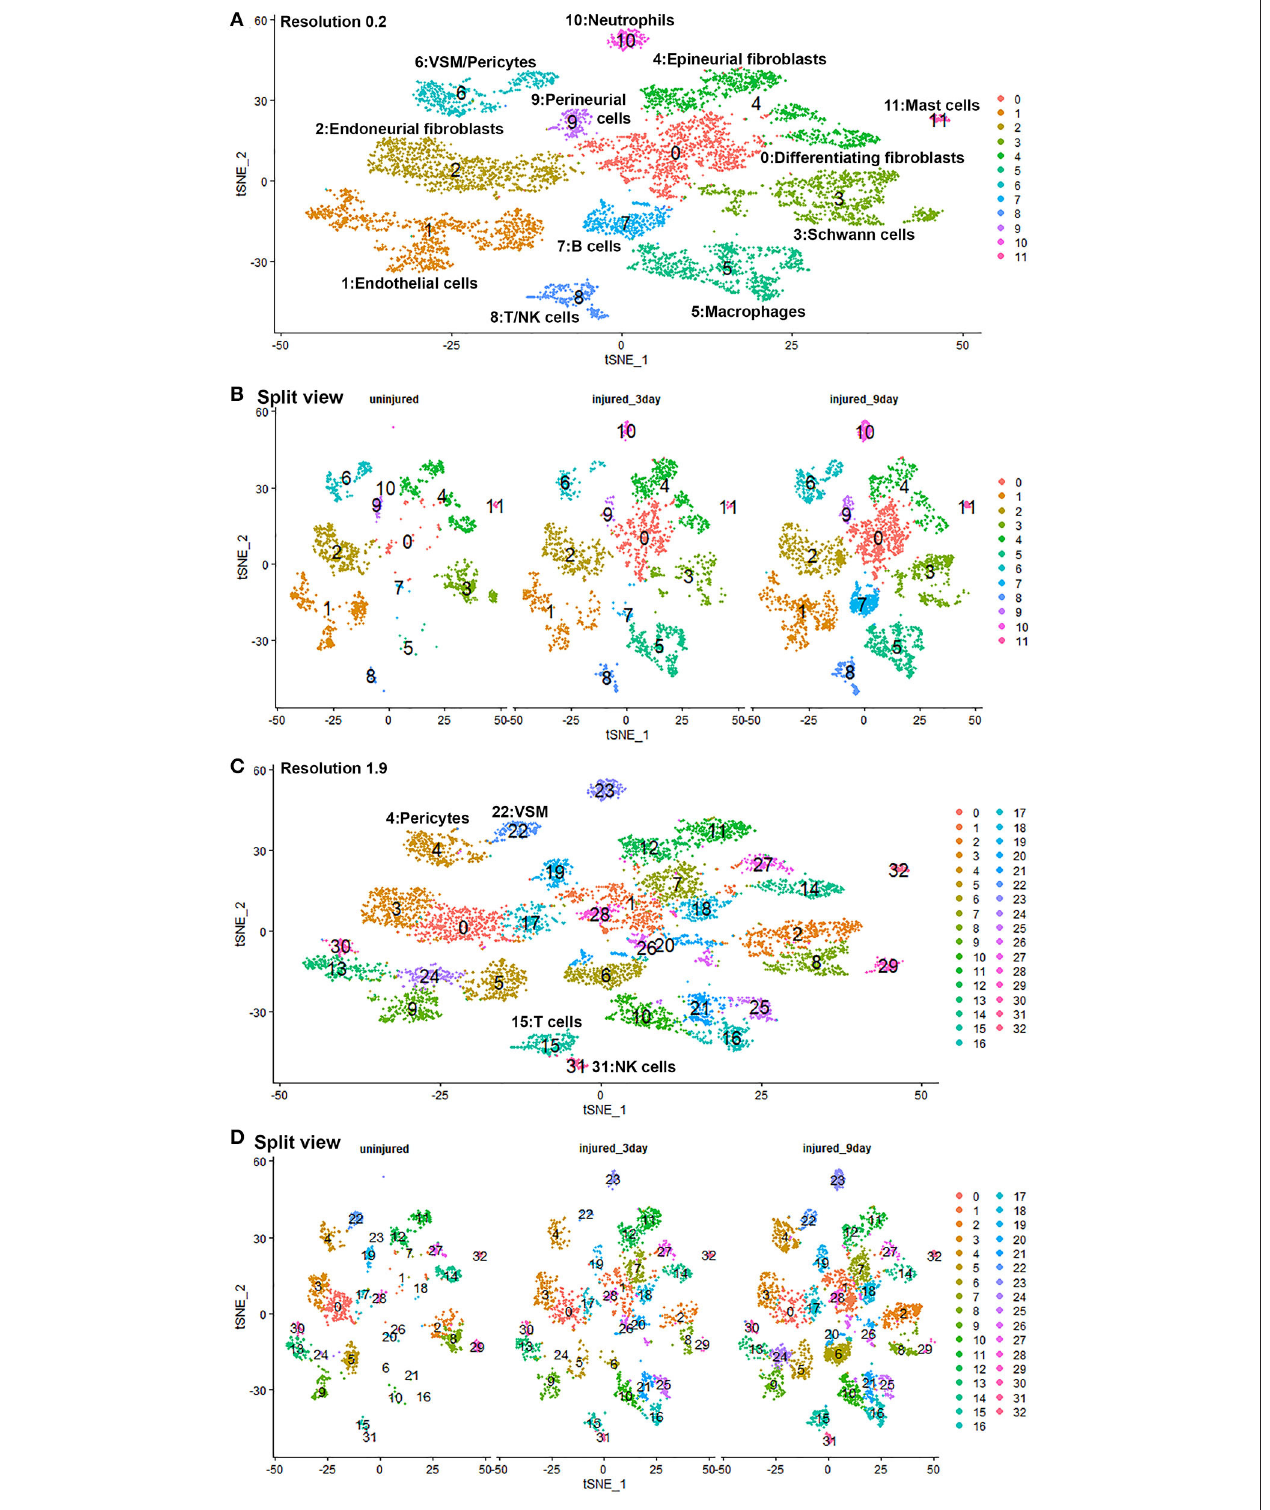
FIGURE 10 | GSE147285 and GSE120678 data sets integrated analysis for intact sciatic nerve and sciatic nerves at day 3 and day 9 post injury. (A) tSNE visualization of cell clusters for integrated analysis at resolution 0.2. NK cells were not separated from T cells, and pericytes were not separated from VSM at resolution 0.2. (B) Split view of cell clusters at resolution 0.2 for intact sciatic nerve and sciatic nerves at day 3 and day 9 post injury. (C) tSNE visualization of cell clusters for integrated analysis at resolution 1.9. NK cells (cluster 31) were separated from T cells (cluster 15), and pericytes (cluster 4) were separated from VSM (cluster 22). (D) Split view of cell clusters at resolution 1.9 for intact sciatic nerve and sciatic nerves at day 3 and day 9 post-injury.